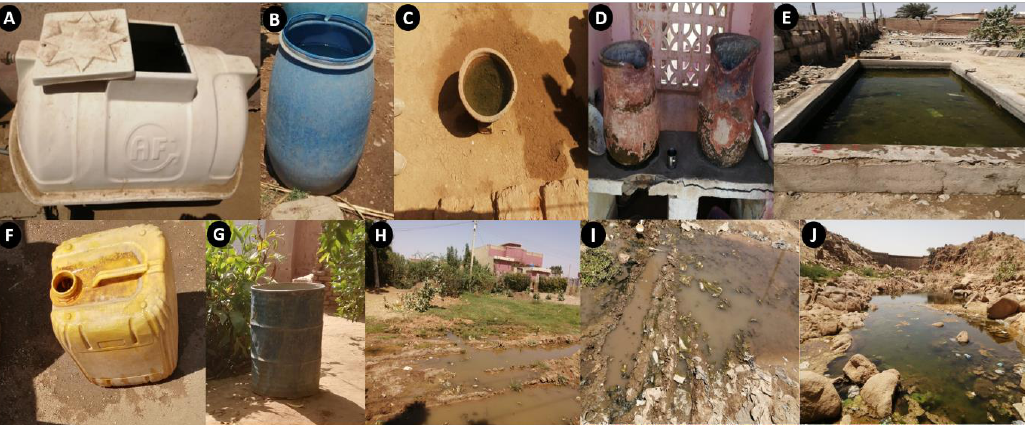
Figure 2. Representative breeding sites that were positive for presence of aquatic stages of An. stephensi (larvae and pupae). ( A ) Plastic cistern, ( B ) plastic barrel, ( C ) mud pot, ( D ) clay pot (Zeir/Jar), ( E ) ground water-basin, ( F ) plastic jerrycan, ( G ) iron barrel, ( H , I ) leakage of broken water supply, and ( J ) rainwater pond trapped in a rocky valley.